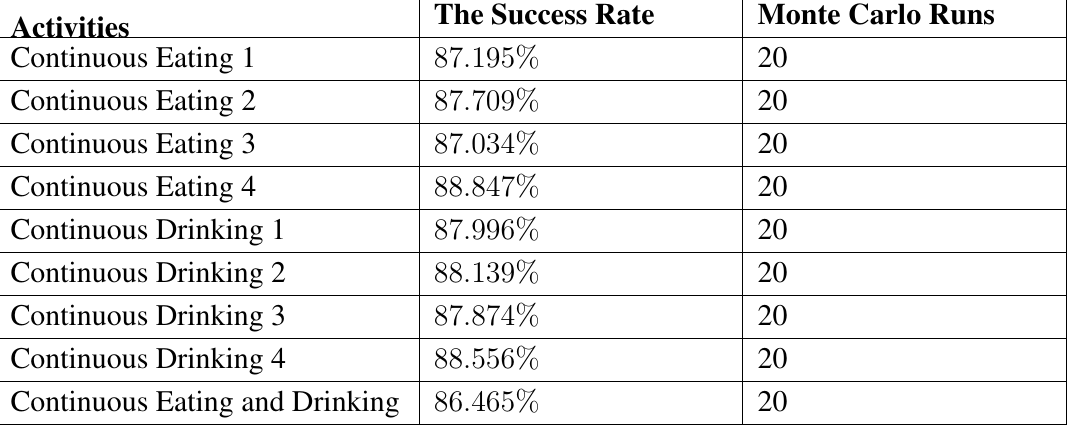
Table 4. The success rate of the eating/drinking detection by the HTM algorithm based on